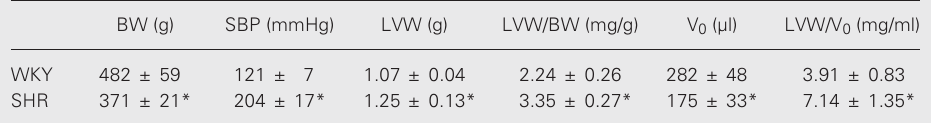
Table 1. Chronic pressure-overload rats compared to controls.